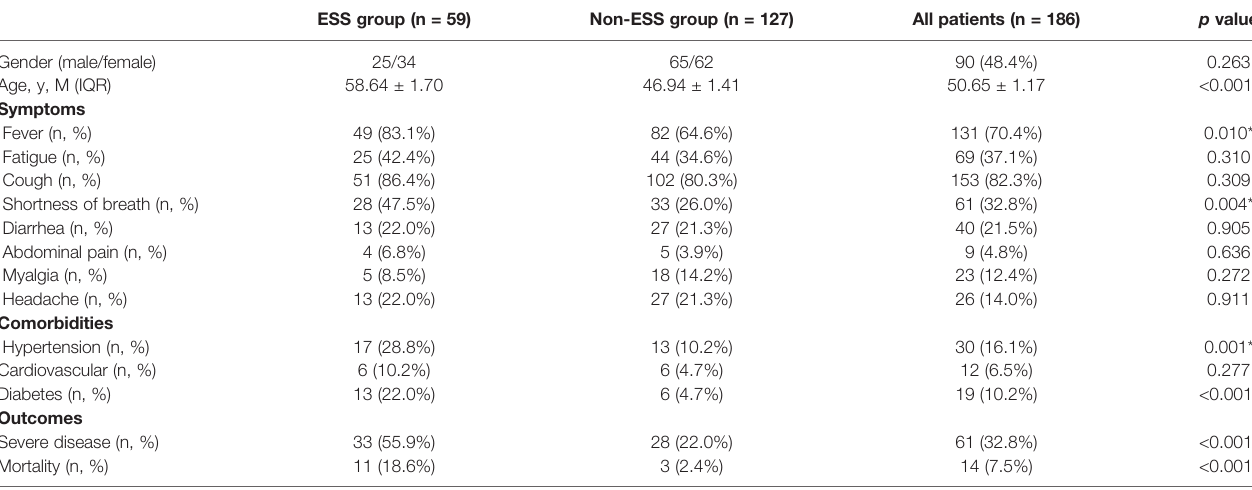
TABLE 2 | Baseline characteristics of patients with ESS and